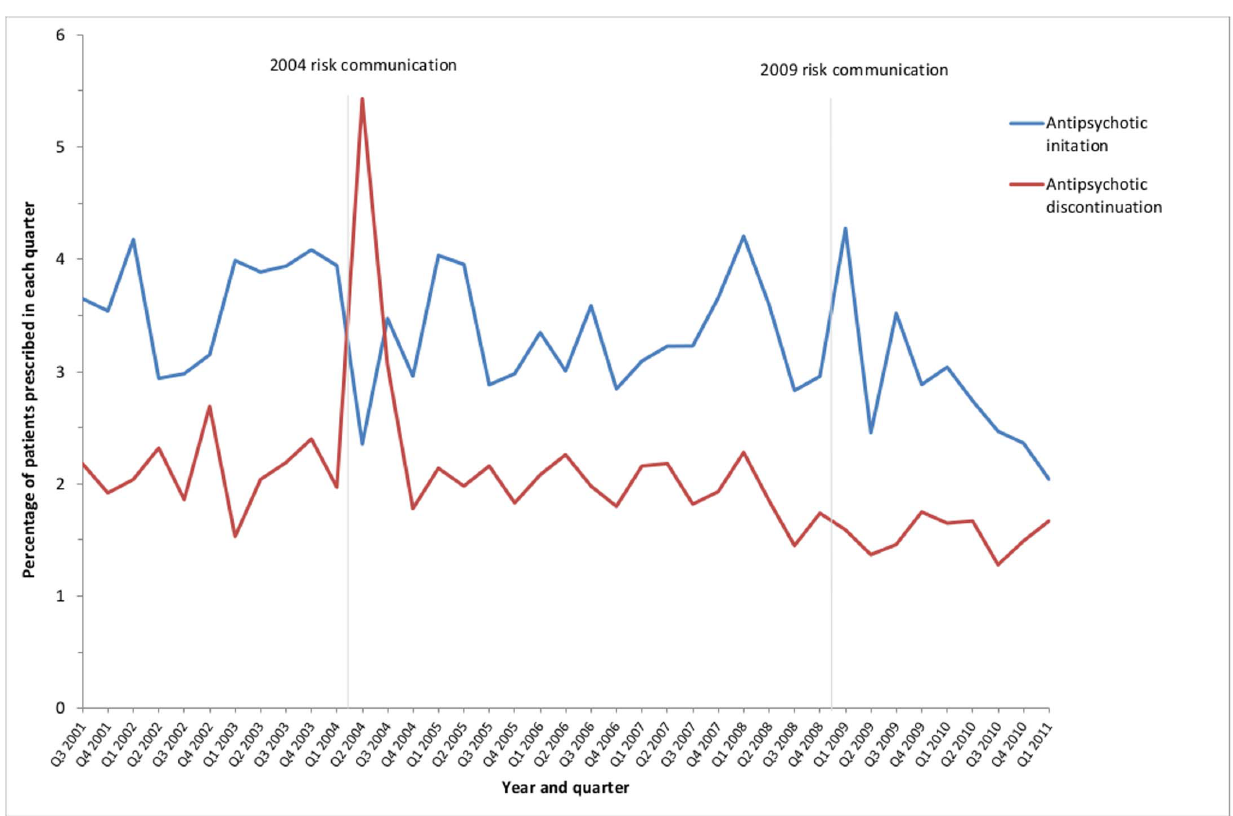
Figure 3. New antipsychotic prescribing and antipsychotic stopping in people aged $ 65 years with dementia.